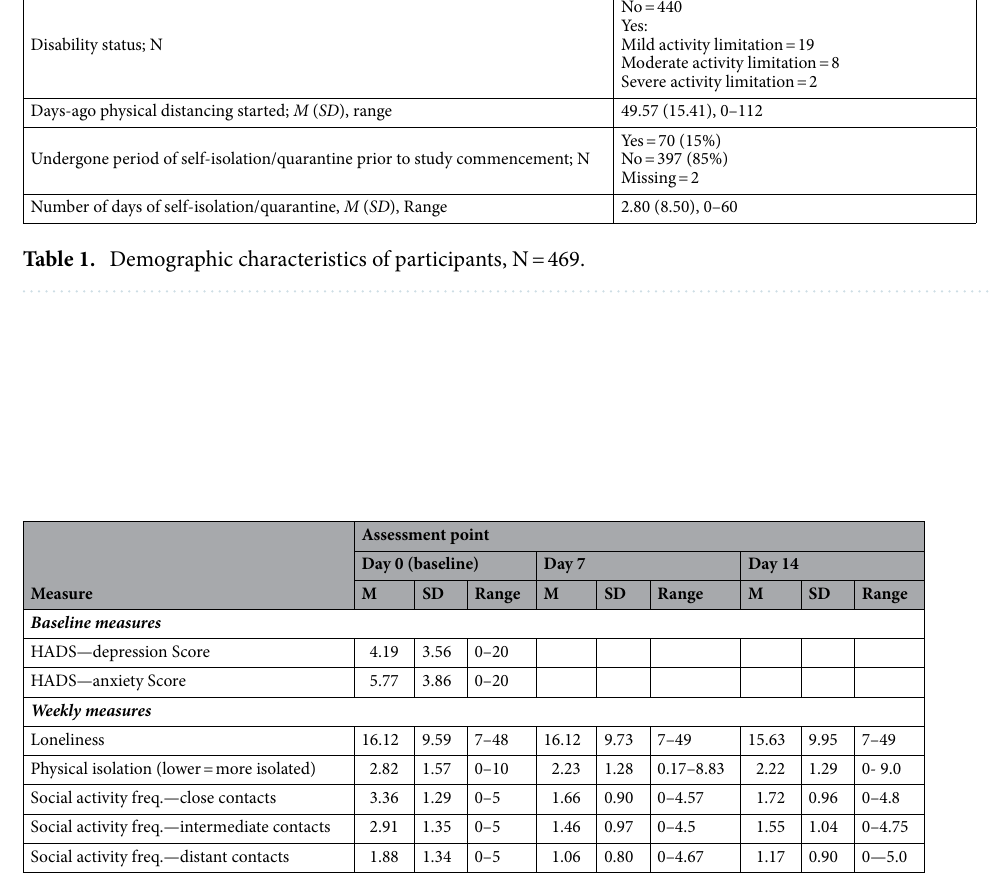
Table 2. Descriptive statistics of baselines and weekly measures across participants, for each assessment